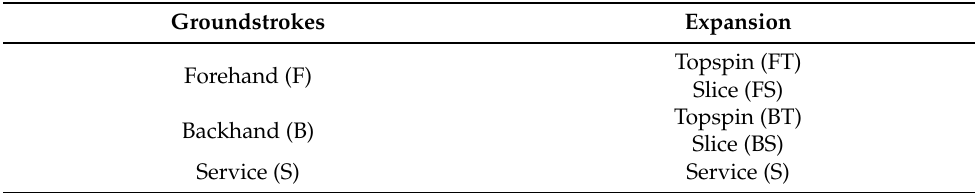
Topspin (FT) Slice (FS) Topspin (BT) Slice (BS)